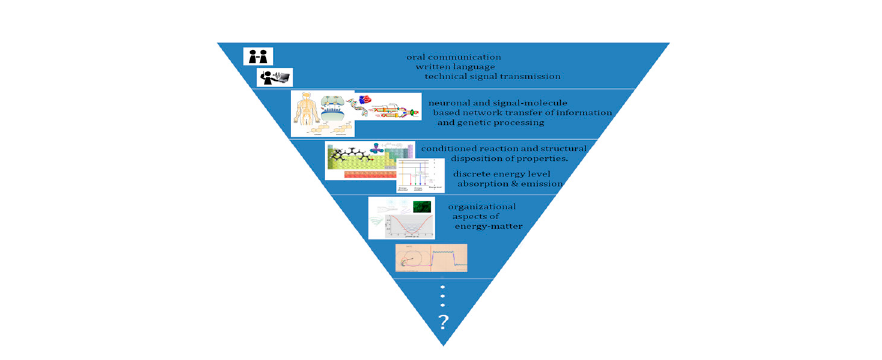
Figure 1. Intuitively established relation between types of information developing recursively in an evolving context of nested